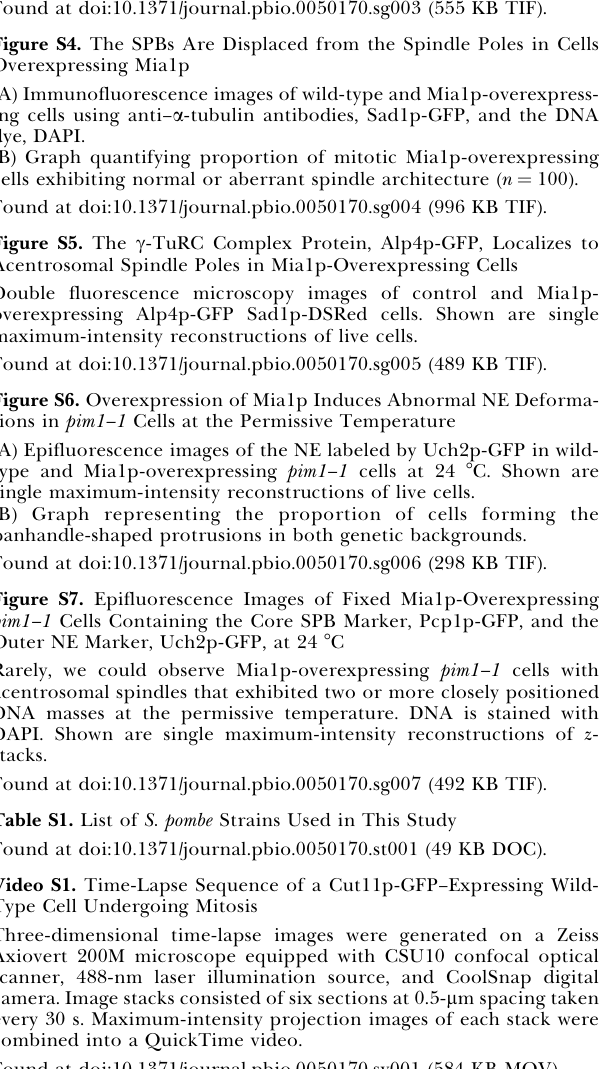
Figure S3. The Majority of Mia1p-Overexpressing Cells Exhibit Mad2p-GFP on the NE Graph quantifying the proportion of cells with Mad2p-GFP on kinetochores in wild type and cells overexpressing Mia1p ( n ¼ 100). Inset displays typical appearance of Mad2p-GFP in Mia1p-over- expressing cells, either on kinetochores or broadly spread around the NE. Shown are single maximum-intensity reconstructions of live cells. Figure S4. The SPBs Are Displaced from the Spindle Poles in Cells Overexpressing Mia1p (A) Immunofluorescence images of wild-type and Mia1p-overexpress- ing cells using anti– a -tubulin antibodies, Sad1p-GFP, and the DNA dye, DAPI. (B) Graph quantifying proportion of mitotic Mia1p-overexpressing cells exhibiting normal or aberrant spindle architecture ( n ¼ 100). Found at doi:10.1371/journal.pbio.0050170.sg004 (996 KB TIF). Figure S5. The c -TuRC Complex Protein, Alp4p-GFP, Localizes to Acentrosomal Spindle Poles in Mia1p-Overexpressing Cells Double fluorescence microscopy images of control and Mia1p- overexpressing Alp4p-GFP Sad1p-DSRed cells. Shown are single maximum-intensity reconstructions of live cells. Figure S6. Overexpression of Mia1p Induces Abnormal NE Deforma- tions in pim1–1 Cells at the Permissive Temperature (A) Epifluorescence images of the NE labeled by Uch2p-GFP in wild- type and Mia1p-overexpressing pim1–1 cells at 24 8 C. Shown are single maximum-intensity reconstructions of live cells. (B) Graph representing the proportion of cells forming the panhandle-shaped protrusions in both genetic backgrounds. Figure S7. Epifluorescence Images of Fixed Mia1p-Overexpressing pim1–1 Cells Containing the Core SPB Marker, Pcp1p-GFP, and the Outer NE Marker, Uch2p-GFP, at 24 8 C Rarely, we could observe Mia1p-overexpressing pim1–1 cells with acentrosomal spindles that exhibited two or more closely positioned DNA masses at the permissive temperature. DNA is stained with DAPI. Shown are single maximum-intensity reconstructions of z - stacks. Table S1. List of S. pombe Strains Used in This Study Found at doi:10.1371/journal.pbio.0050170.st001 (49 KB DOC). Video S1. Time-Lapse Sequence of a Cut11p-GFP–Expressing Wild- Type Cell Undergoing Mitosis Three-dimensional time-lapse images were generated on a Zeiss Axiovert 200M microscope equipped with CSU10 confocal optical scanner, 488-nm laser illumination source, and CoolSnap digital camera. Image stacks consisted of six sections at 0.5- l m spacing taken every 30 s. Maximum-intensity projection images of each stack were combined into a QuickTime video. Found at doi:10.1371/journal.pbio.0050170.sv001 (584 KB MOV). Video S2. Time-Lapse Sequence of a Mia1p-Overexpressing Cut11p- GFP Cell Undergoing Mitosis Three-dimensional time-lapse images were generated on a Zeiss Axiovert 200M microscope equipped with CSU10 confocal optical scanner, 488-nm laser illumination source, and CoolSnap digital camera. Image stacks consisted of six sections at 0.5- l m spacing